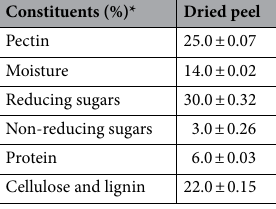
Table 1. The composition of dried banana peel. *On dry weight basis (total solids = 80 ± 0.03). Mean ± SE values (n = 3).